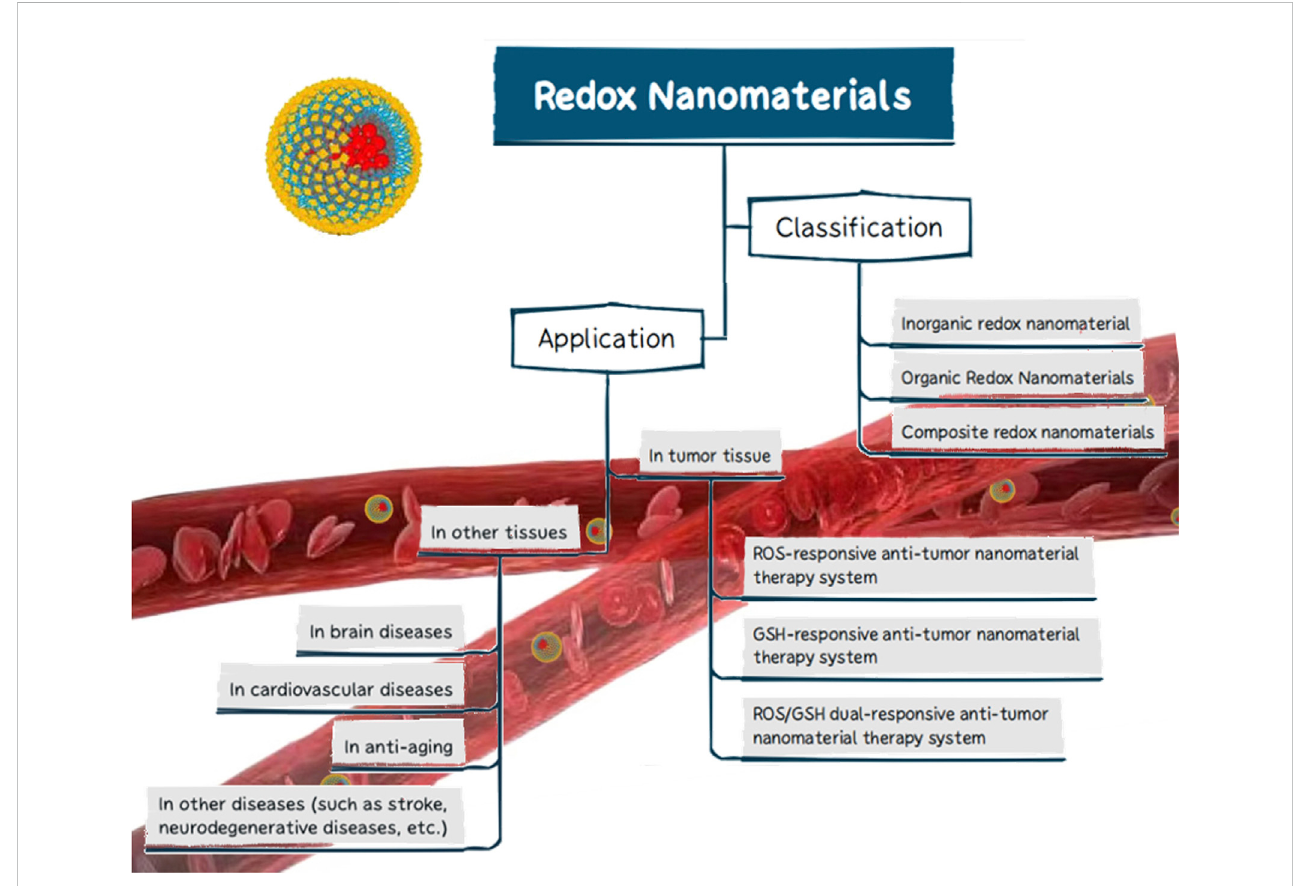
FIGURE 1 The classi fi cation and application of redox